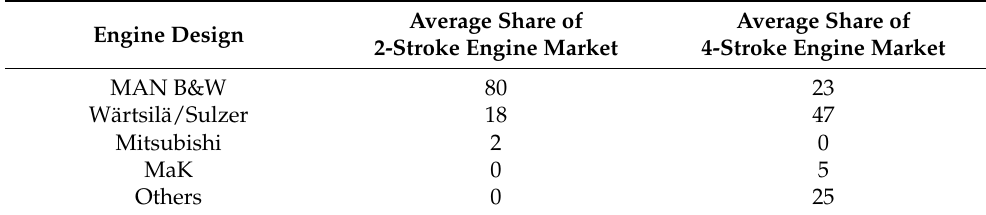
Table A2. Average share of engine design among main ship engines in the world fleet in 2012–2013 (Wärtsilä, 2012, research in China